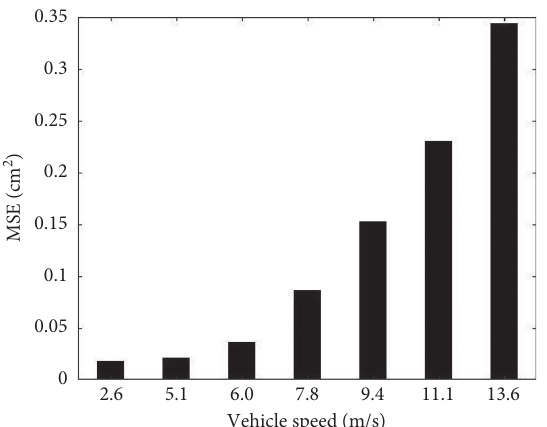
Figure 8: The estimated pavement profile for two cases with maximum MSEs shown in Figure 7. (a) ω (b) ω n � 9.68 rad/s and ζ �